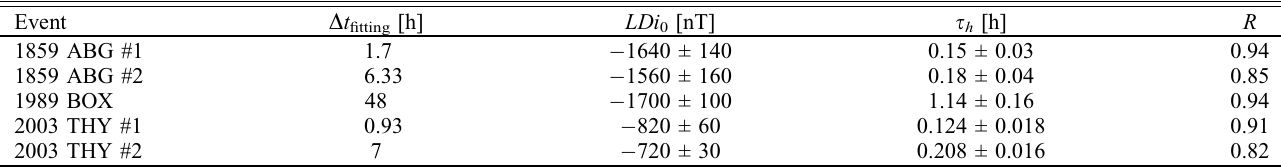
Table 1. This table presents several parameters of the hyperbolic fitting for the events. Event